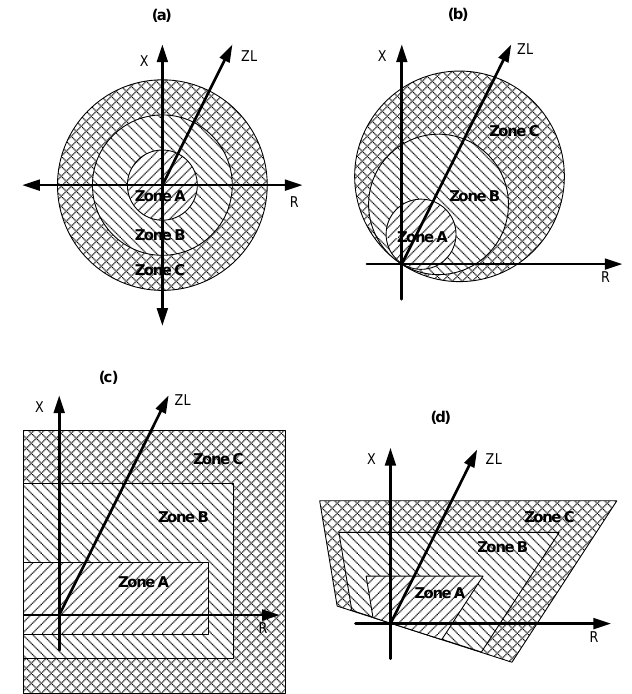
Figure 2. Types of impedance relay characteristics with three zone settings: ( a ) Impedance relay; ( b ) Mho relay; ( c ) Reactance relay; ( d ) Quadrilateral relay.